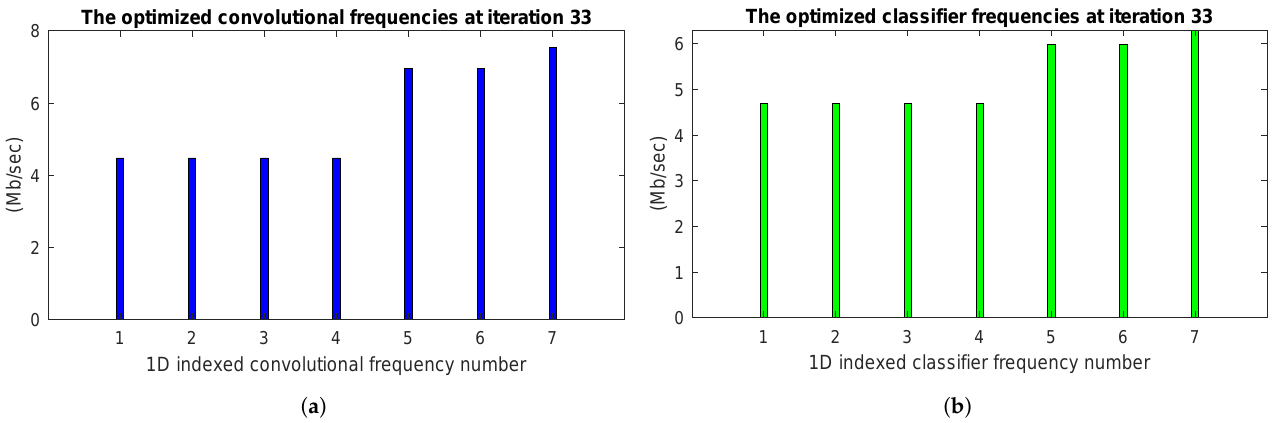
Figure 10. Values under topology T 1 of the final optimized frequencies of the: ( a ) convolutional processors and ( b ) classifier